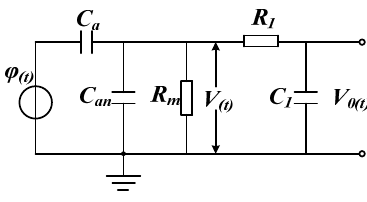
Figure 6. Equivalent circuit model.